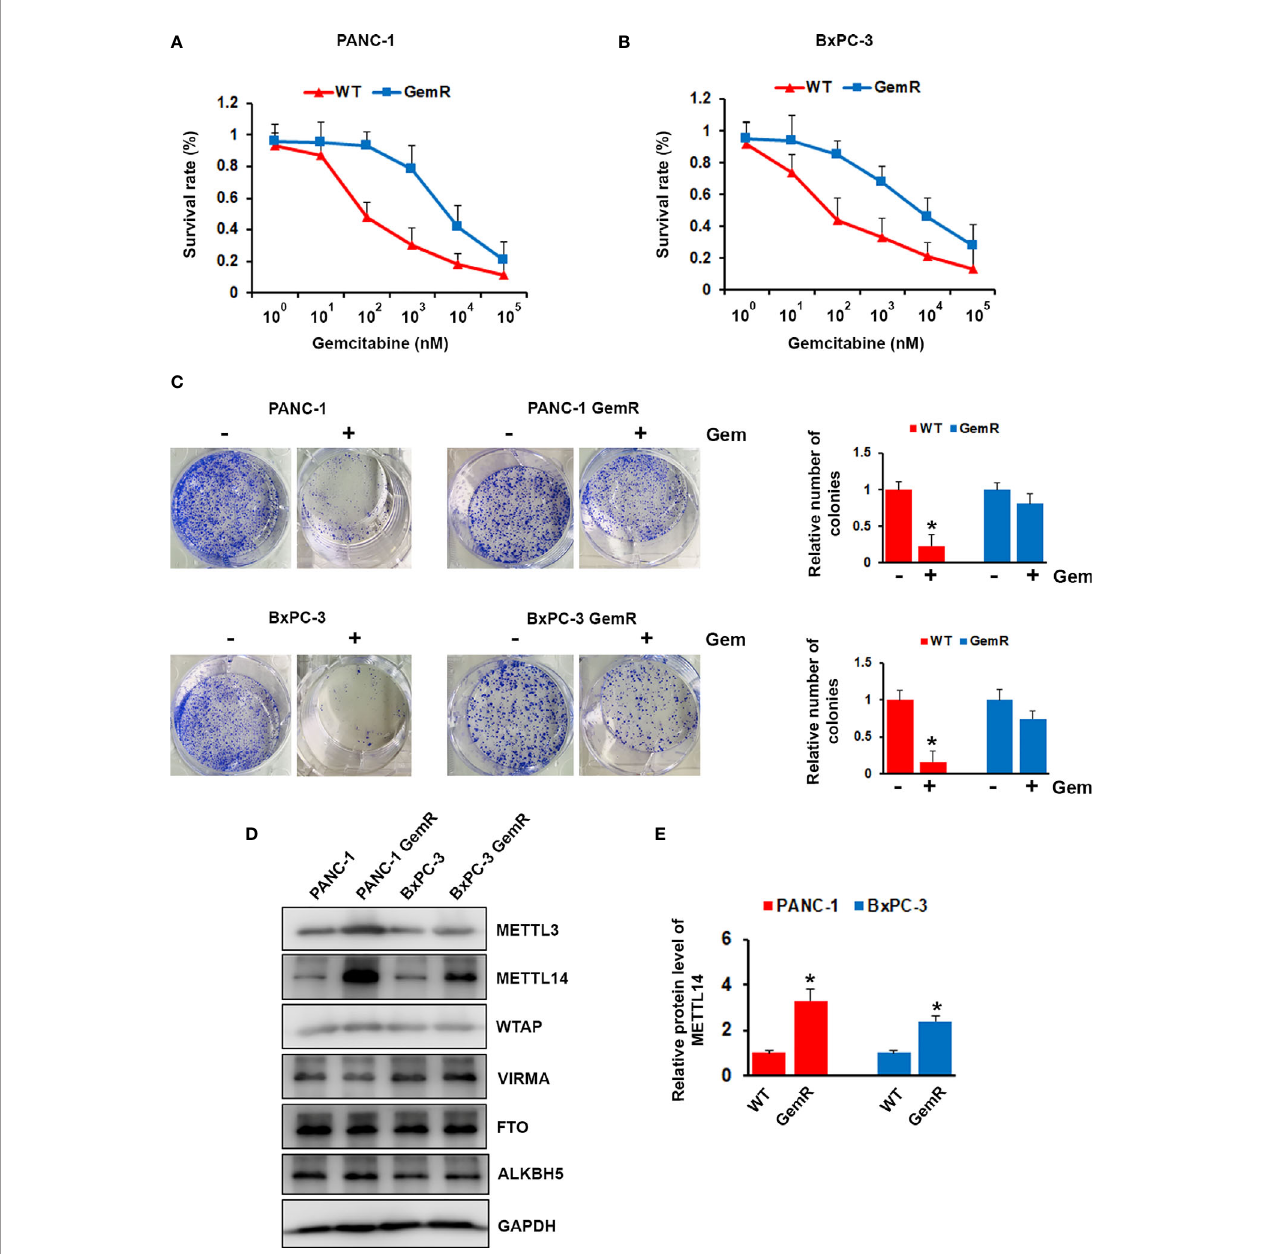
FIGURE 2 | Aberrant expression of METTL14 in gemcitabine resistant pancreatic cancer cells. (A, B) PANC-1 GemR (A) /BxPC-3 GemR (B) and their parental wild type cells were treated with indicated concentration of gemcitabine for 72 hours, cell survival was assessed by MTT assay. (C) PANC-1 GemR/BxPC-3 GemR and their parental wild type cells were performed colony formation assay after treated with gemcitabine. (D) The protein level of METTL3, METTL14, WTAP, VIRMA, FTO, and ALKBH5 was assessed by western blotting in PANC-1 GemR/BxPC-3 GemR and their parental wild type cells. (E) Quanti fi cation of METTL14 protein levels in wild type (WT) or gemcitabine resistant (GemR) pancreatic cancer cells. Data are reported as means ± SEM of values from three experiments. *p <